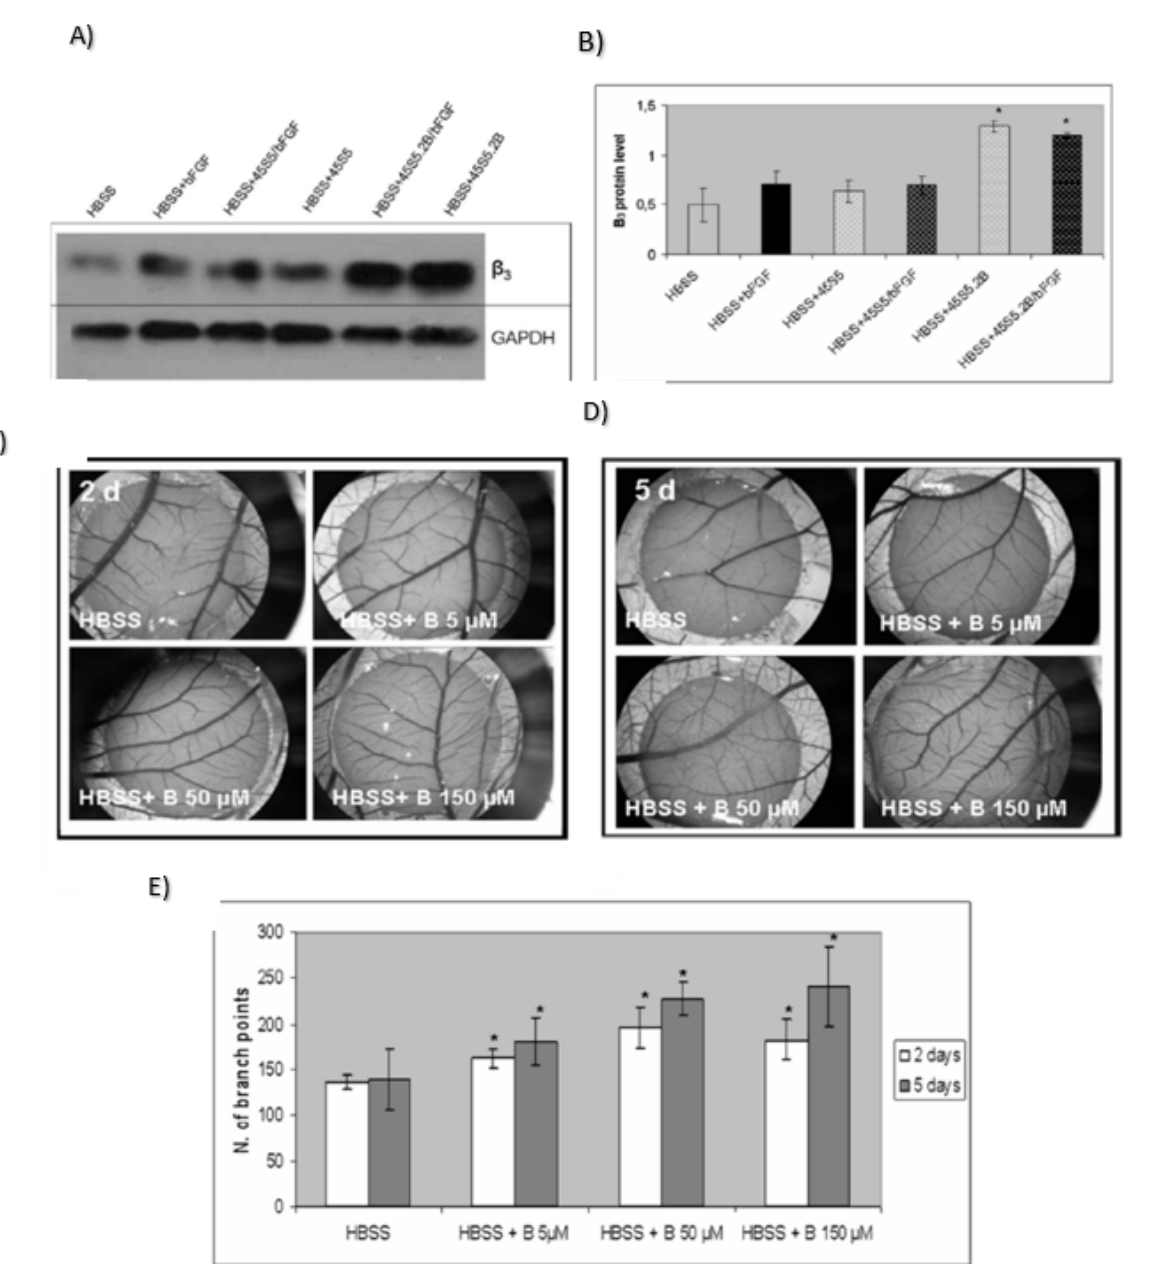
Figure 11. ( A ) Western blot and subunit of integrin α v β 3 relative expression. ( B ) * shows p < 0.5 for HBSS.2B and HBSS/bFgF for statistical analysis. ( C ) shows various borate concentration angiogenesis effects of CAM at 2 d. ( D ) shows various borate concentration angiogenesis effects of CAM at 2 days and 5 days posttreatment. ( E ) The number of branch points with different concentrations of borate at 2 and 5 days. Adapted from [174]. Reproduced with permission from RSC.